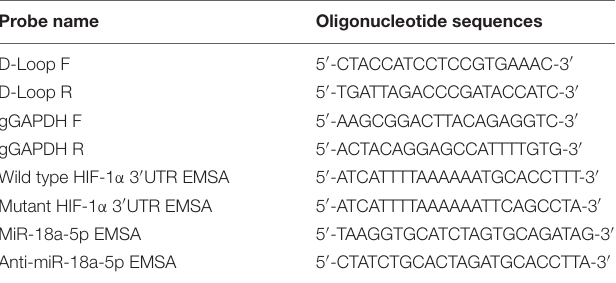
TABLE 2 | Details of PCR primers and EMSA probes.